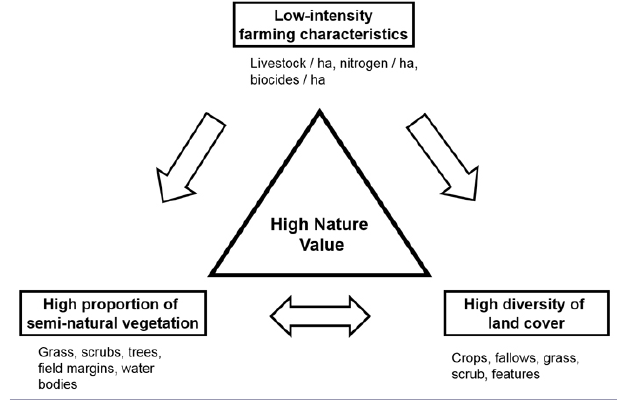
Fig. 2 . Key characteristics of HNV (high-nature-value) farming. Reproduced from Cooper et al.